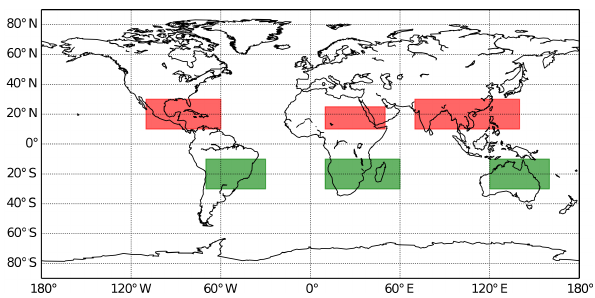
Figure 2. Regions of deep convection. For the Northern Hemi- sphere, three regions of deep convection are demonstrated by three red rectangles. For the Southern Hemisphere, three regions of deep convection are indicated by three green rectangles.